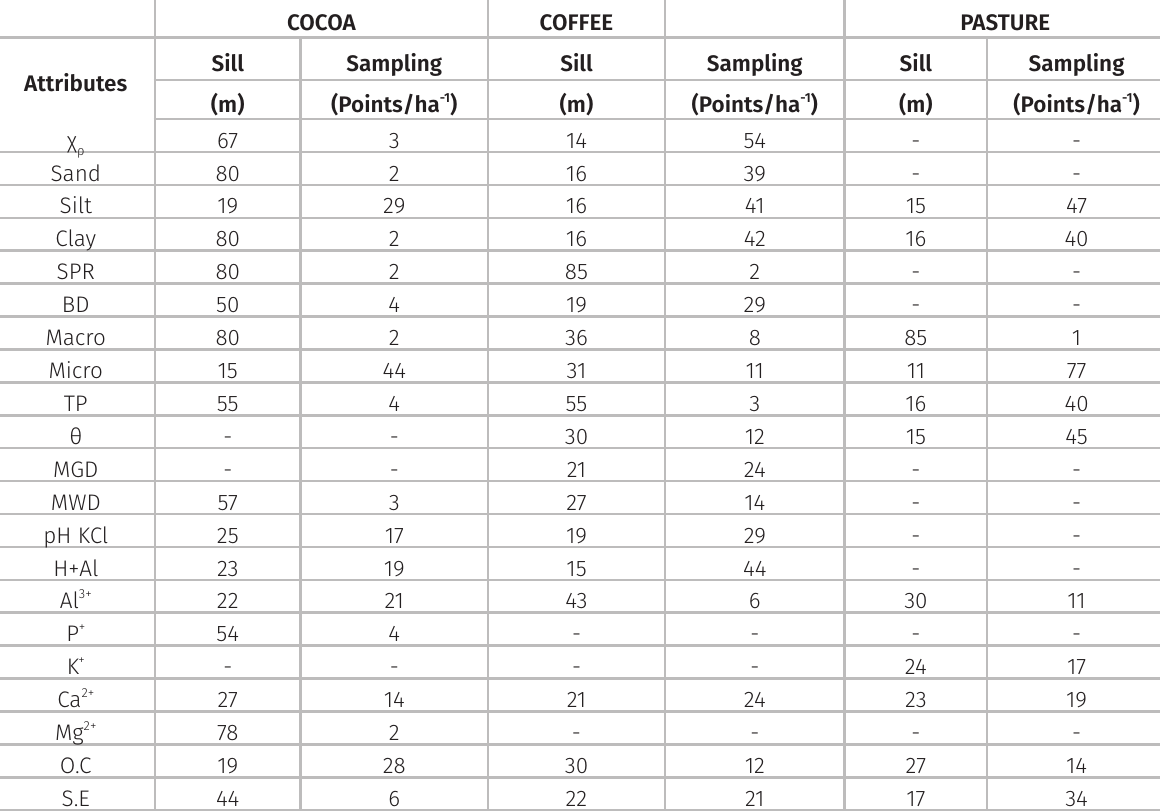
Table III. Minimum sample density based on the reach of semivariograms adjusted of soil attributes and magnetic susceptibility in areas of Indian Black Earth under uses with cocoa, coffee and pasture. COCOA COFFEE PASTURE Sill Sampling Sill Sampling Attributes